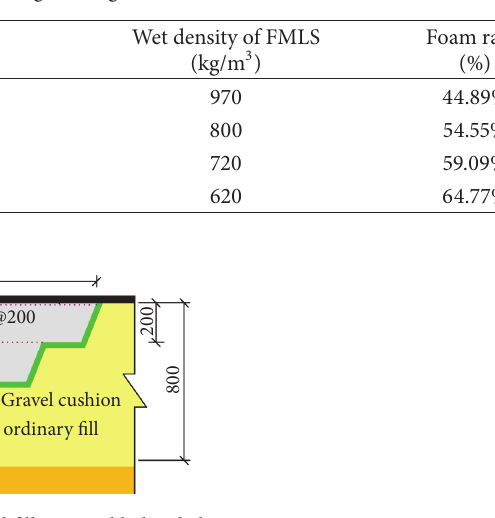
Table 6: Mixture proportion in the practical engineering of FMLS.